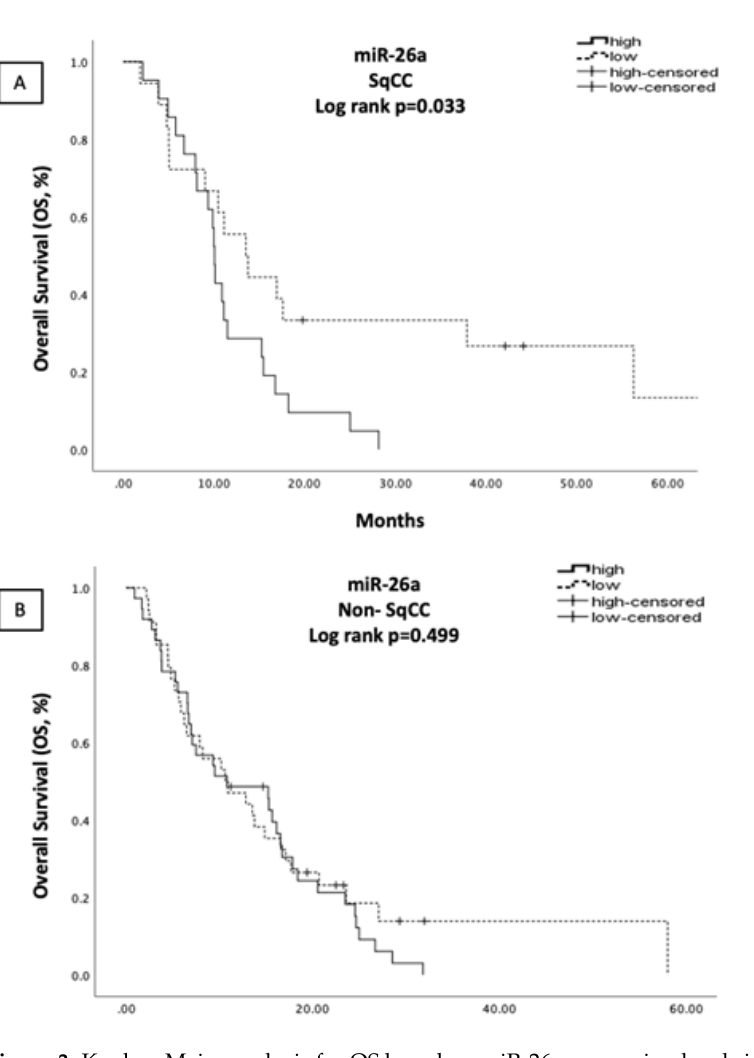
Figure 3. Kaplan–Meier analysis for OS based on miR-26a expression levels in the plasma of SqCC ( A , N = 40) and non-SqCC ( B , N = 85) NSCLC patients. Median expression values classified patients into high and low expression groups. Curves were compared using the log rank test; p -values are shown. In the non-SqCC subgroup, low miR-26 was associated with the presence of brain metastases (78.6% vs. 21.4%, low vs. high, respectively; p = 0.011). No other correlations were observed when comparing miRNA expression and clinicopathological characteris- tics in this patient subset. Patients with high miR-202 expression had shorter median PFS and OS compared to those with low miR-202 expression (4.17 vs. 5.80 months, p = 0.050; and 6.27 vs. 15.30 months, p = 0.012) (Figure 4A and 4B, respectively). The remaining miR- NAs had no statistically significant associations with survival measures (Figure S4 and S5). High miR-202 expression (HR: 1.989, 95% CI: 1.196–3.309; p = 0.008), however, emerged as the only independent prognostic factor for worse OS in the non-SqCC sub- group (Table S5).